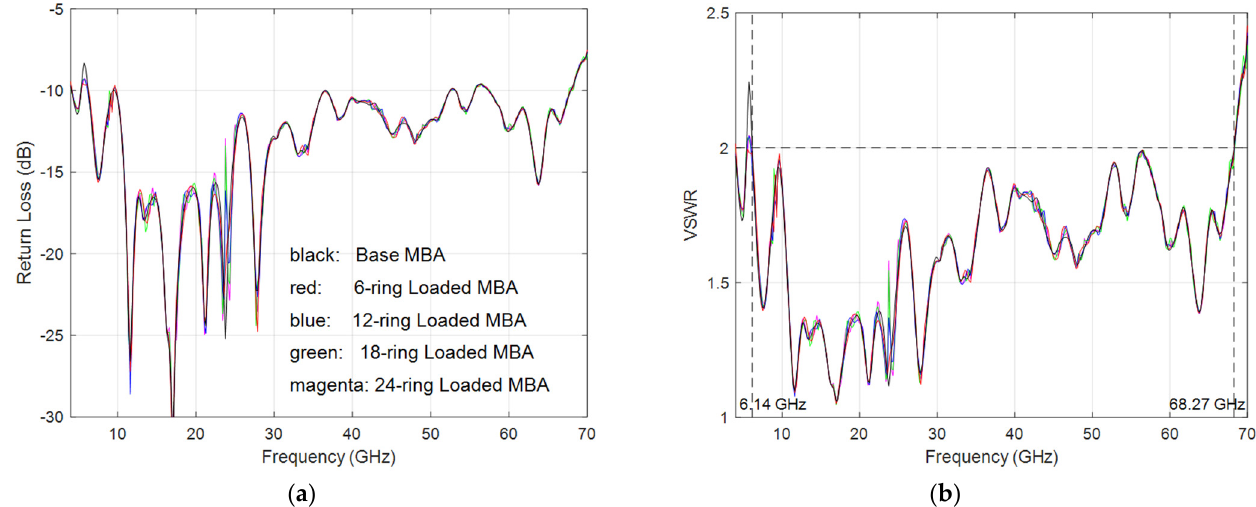
Figure 14. ( a ) Return loss and ( b ) VSWR of metallic-ring-loaded MBAs with an equal number of rings on both sides of the base MBA.